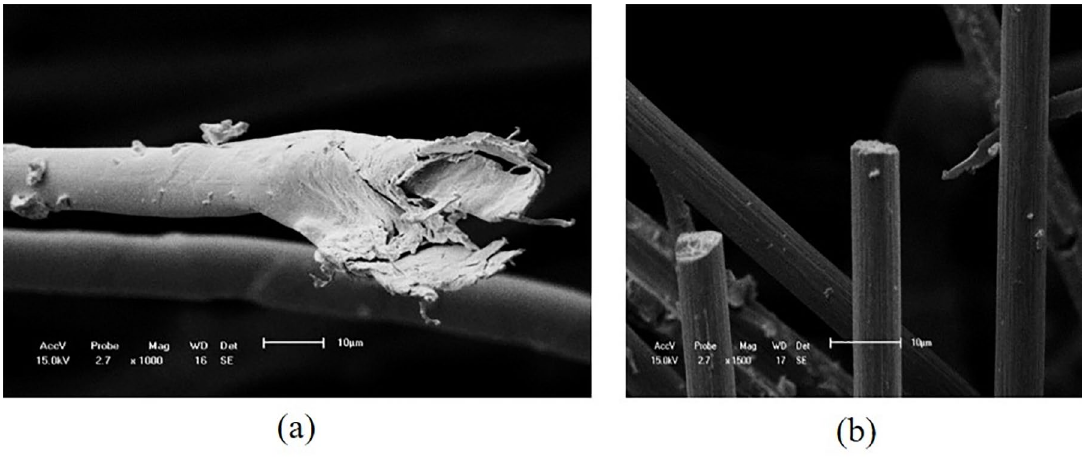
Figure 8. Different forms of mechanical fracture: (a) Kevlar fiber fraying; (b) carbon fiber brittle